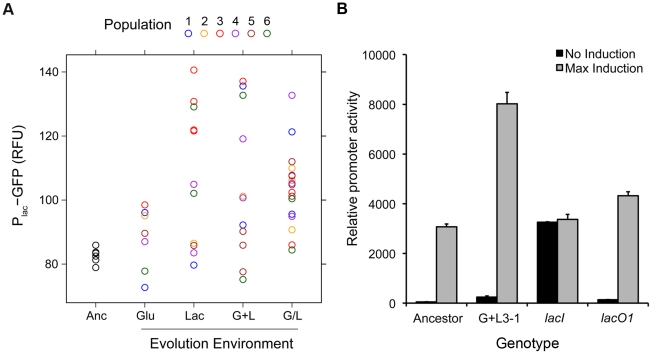
Changes in maximal lac expression for evolved clones.A) Steady state Plac-GFP levels (RFU) are shown for evolved clones grown in the presence of 100 µM TMG. Clones are divided into categories by evolution environment: Glu, Lac, G+L and G/L. Markers of the same color denote clones recovered from the same evolved population. Data points are the average of two independent replicates. As a reference, data for six independent ancestral (Anc) samples is also shown. B) Native lac promoter activity for the ancestor, evolved clone G+L3-1 and the ancestor with lacI and lacO1 mutations. Basal promoter activity was measured for strains grown in the absence of inducer, and maximum promoter activity was measured in the presence of saturating levels of inducer.